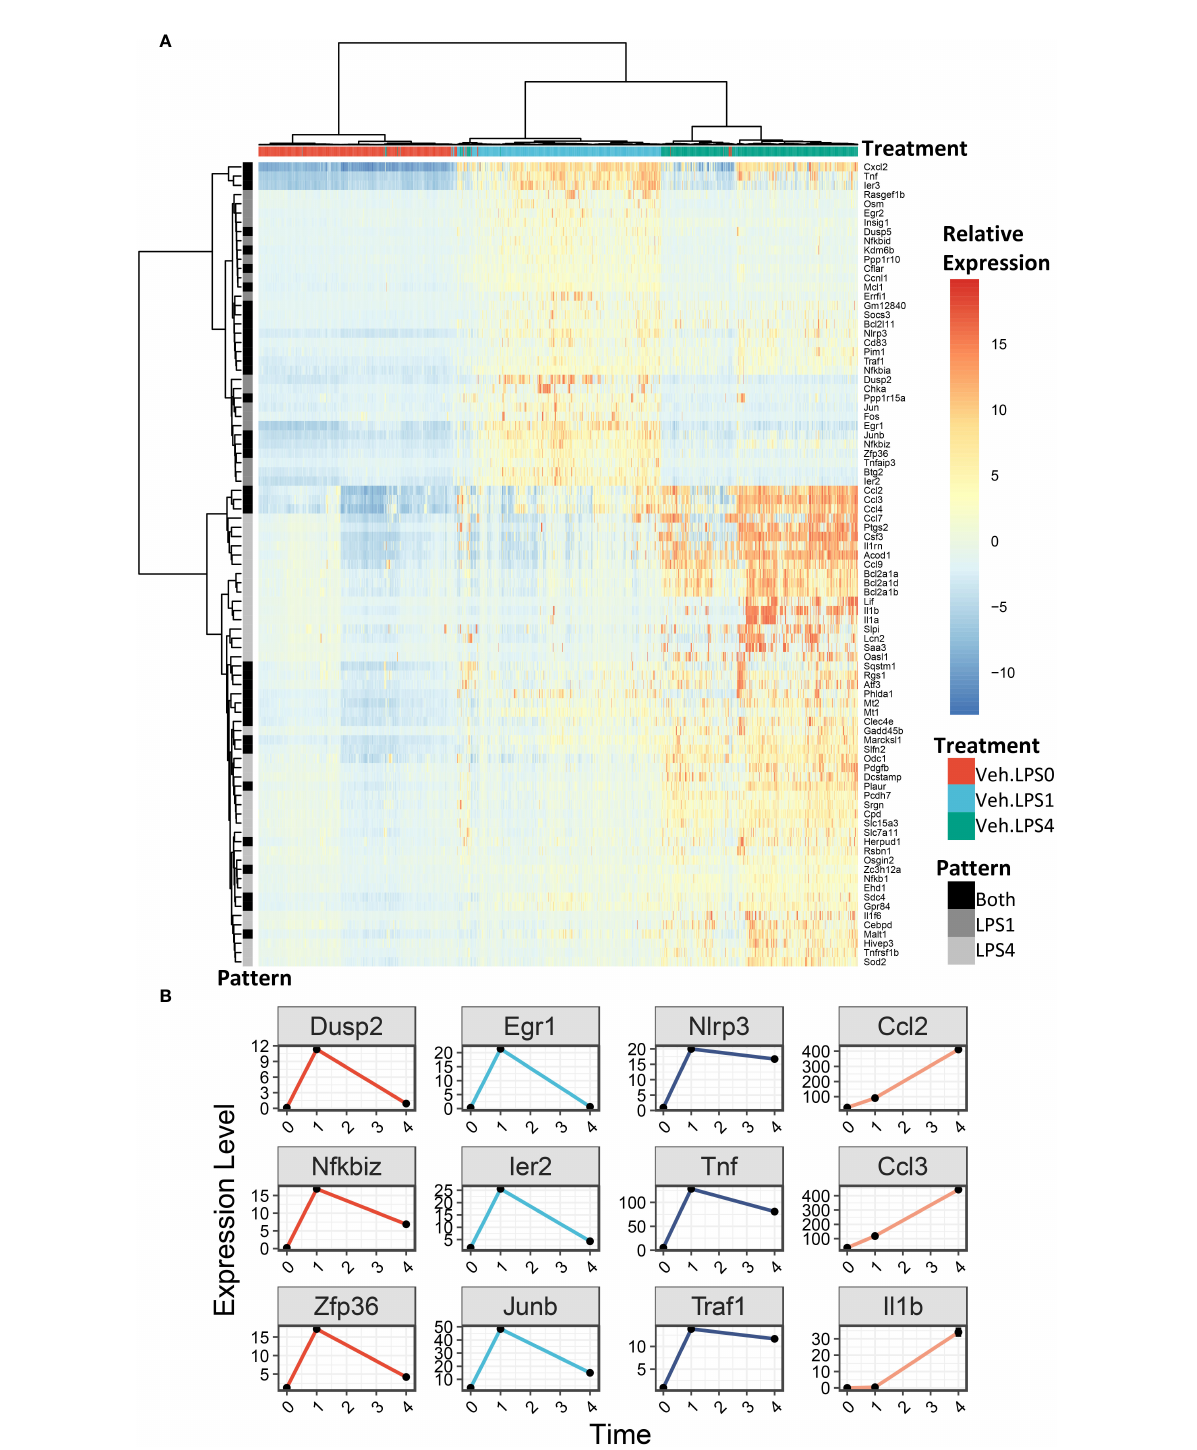
FIGURE 6 LPS robustly upregulates gene expression in FLMs after 1 and 4h. (A) 500 cells were randomly selected from the Veh.0, Veh.LPS.1, and Veh.LPS.4 groups and genes upregulated >6-fold were used to generate a heatmap using pheatmap with the “ ward.d ” clustering method. The normalized SCT values were plotted without scaling the heatmap. Cells were annotated according to their treatment group. (B) Plots showing the expression of individual LPS-induced genes at the 0, 1, and 4 h